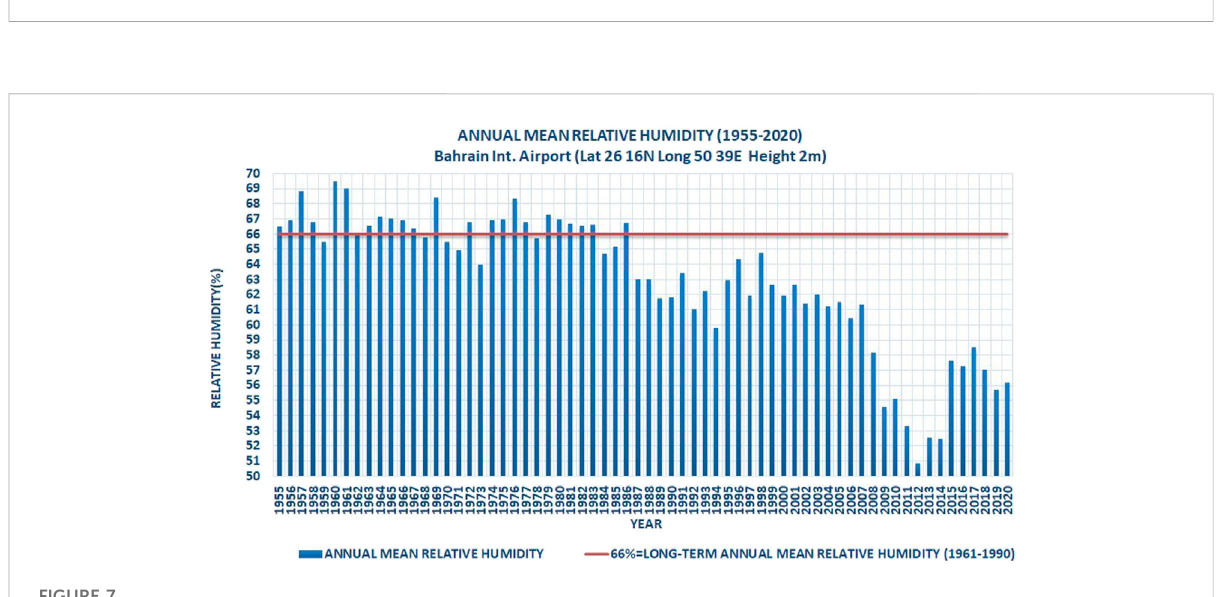
FIGURE 7 Variation ofannualmean average temperature relative inthe Kingdom of Bahrain from1955 to 2020. The long-term annualmean temperature is 66% (average of data from 1961 to 1990).